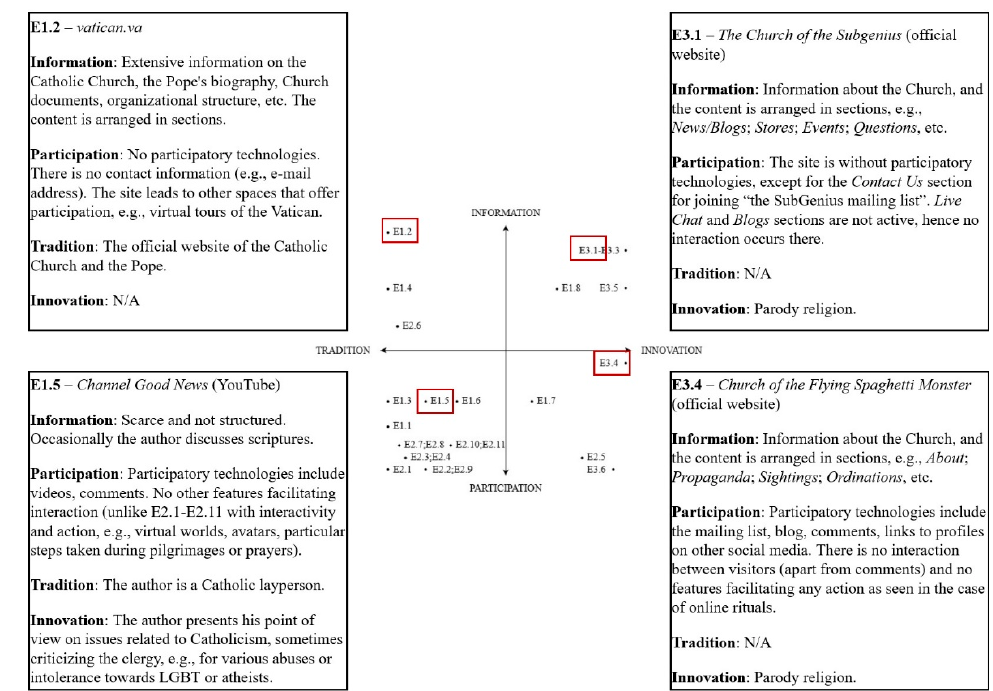
Figure 2. The visual frame for mapping online religious spaces with placed examples.